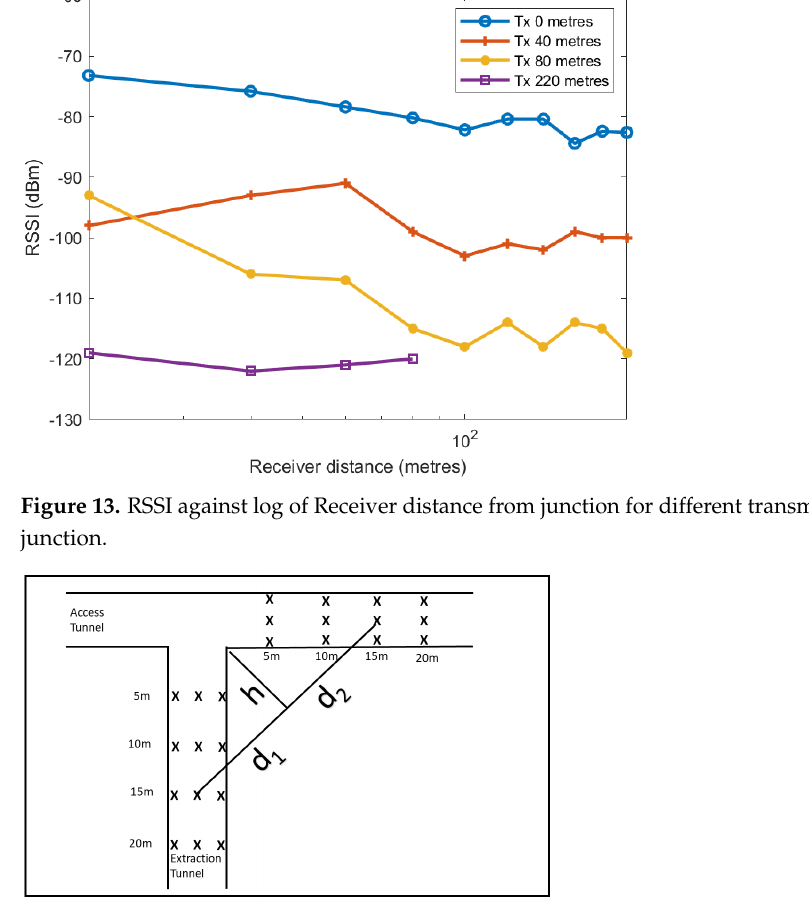
Figure 14. Knife edge diffraction modelling. Transmitter and Receiver locations shown by